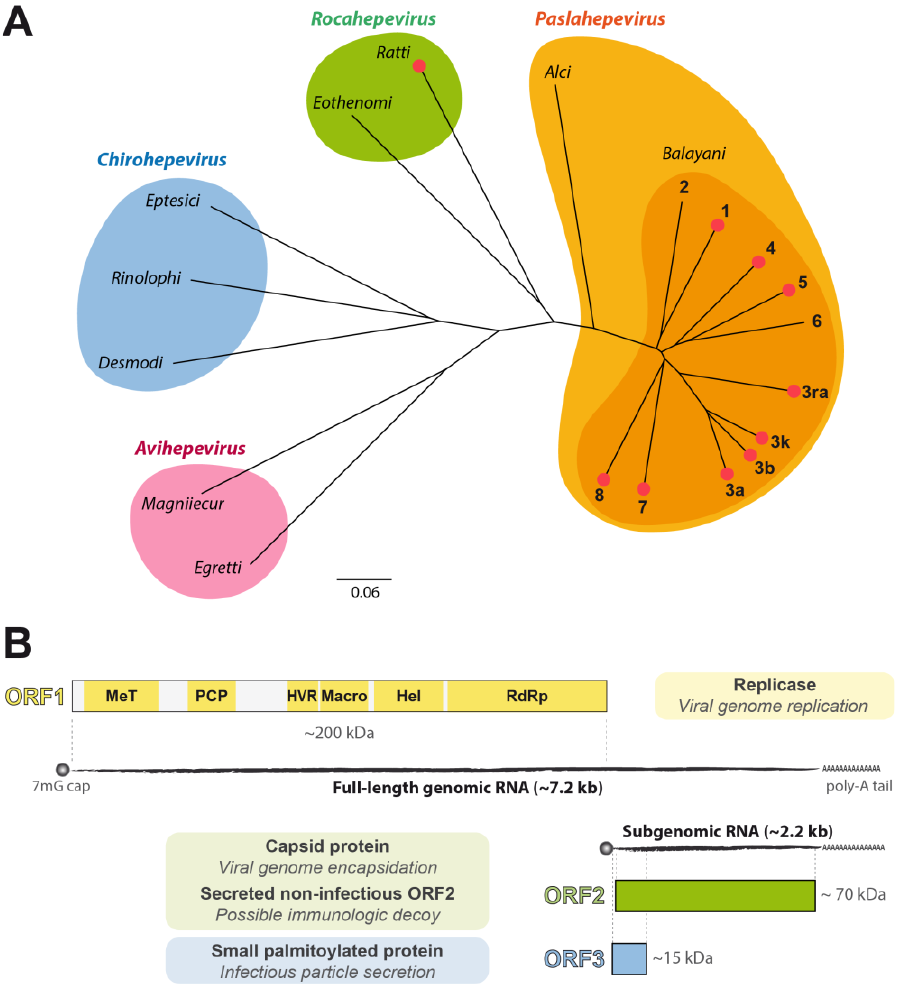
Figure 1. Phylogenetic relationship of the Orthohepevirinae and genomic organization of hepatitis E virus (HEV). ( A ) Sequences of full-length genomes from various viruses of the Orthohepevirinae subfamily were aligned with MUSCLE, followed by phylogenetic tree building using the neighbor-joining method (Geneious Prime software, Biomatters). The name of the vi- ral strain and the corresponding accession numbers are the following: HEV-1, Sar55 (AF444002); HEV-2, Mexican strain (HPENSSP); HEV-3k, HEV83-2-27 (AB740232); HEV-3b, pJE03-1760F (LC126332); HEV-3a, Kernow-C1 (JQ679014); HEV-3ra, rbIM223LR (LC484431); HEV-4, TW6196E (HQ634346); HEV-5, JBOAR135-Shiz09 (AB573435); HEV-6, wbJOY_06 (AB602441); HEV-7, 180C (KJ496144); HEV-8, M2 (MH410176); Paslahep. Alci , AlgSwe2012 (KF951328); Rocahep. ratti , LA-B350 (KM516906); Rocahep. eothenomi , KS_10_1641/GER/2009 (MK192405); Chirohep. rinolophi , HEV/Shanxi2013 (KJ562187); Chirohep eptesici, BtHEVMd2350 (KX513953); Chirohep. desmodi , DesRot/Peru/API17_F_DrHEV (MW249011); Avihep. magniiecur (AY535004); and Avihep. egretti , kocsag02/2014/HUN (KX589065). Sequences for which a molecular clone is available are in- dicated by a red dot. The scale bar indicates the number of nucleotide substitutions per site. ( B ) HEV possesses a 7.2-kb positive-strand RNA genome with a 5 (cid:48) 7-methylguanylate cap (m7G cap) and a 3 (cid:48) polyadenylated tail (poly-A) composed of, at least, three open reading frames (ORF). ORF1 encodes the viral replicase composed of several functional domains, including a methyltransferase (MeT), a putative papain-like cysteine protease (PCP), a hypervariable region (HVR), a macro domain, an RNA helicase (Hel), and an RNA-dependent RNA polymerase (RdRp). During RNA replication, a subgenomic RNA species is generated and gives rise to the expression of ORF2 and ORF3 proteins, respectively, the viral capsid, produced in different forms (not represented here), and a small protein involved in virus